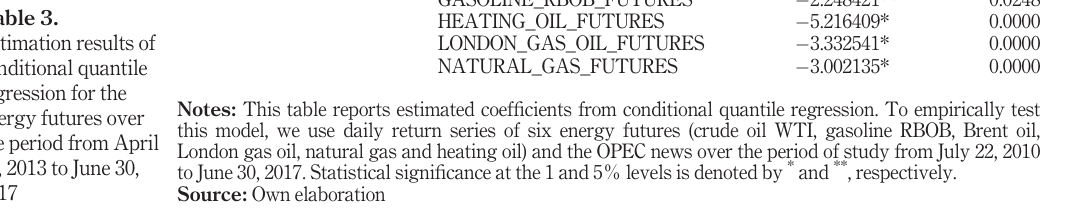
Table 3. Estimation results of